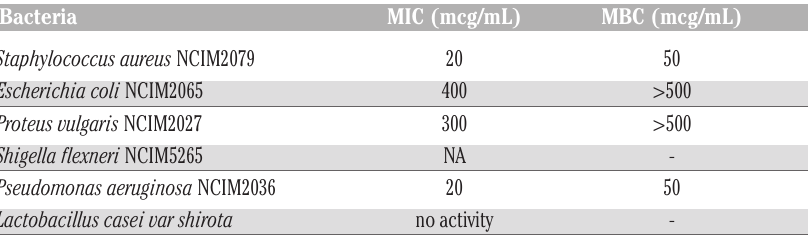
Table 1. Minimum inhibitory concentration (MIC) and minimum bactericidal concen- tration (MBC) of quercetin.